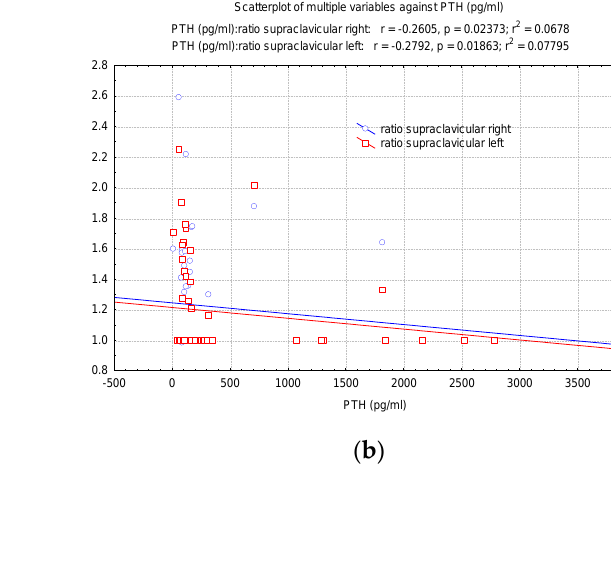
ratio cervical right ratio cervical left